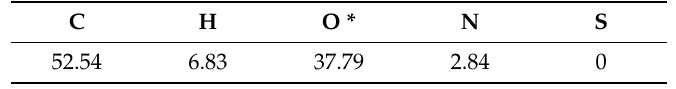
Table 2. Elemental composition (wt%) of co ff ee ground (dry and ash-free basis).